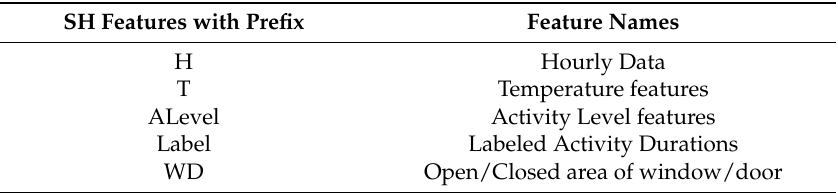
Table 13. Summary of SH feature name explanation, organized by